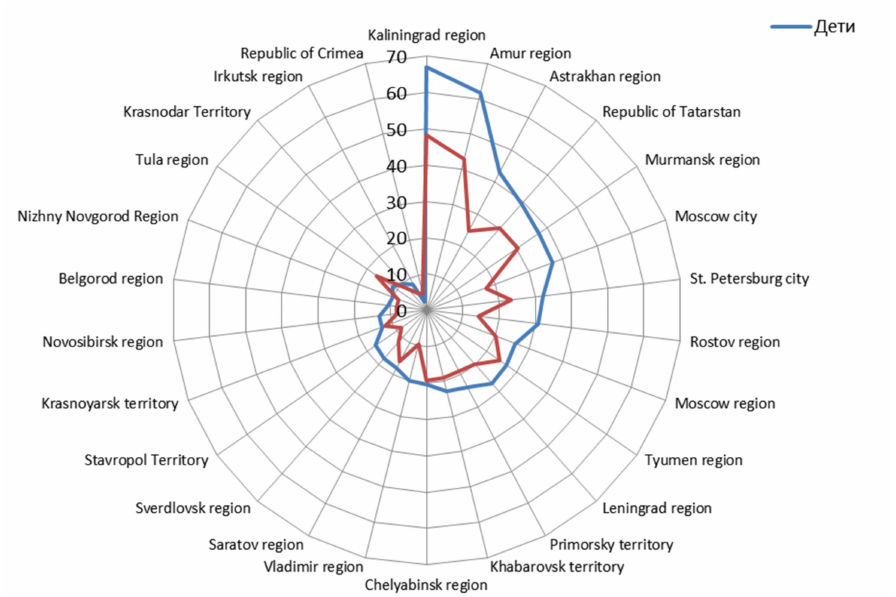
Figure 2. Distribution of seropositive volunteer proportions in the child cohort (blue curve) and adult cohort (red curve). The vertical axis is the percent seroprevalence